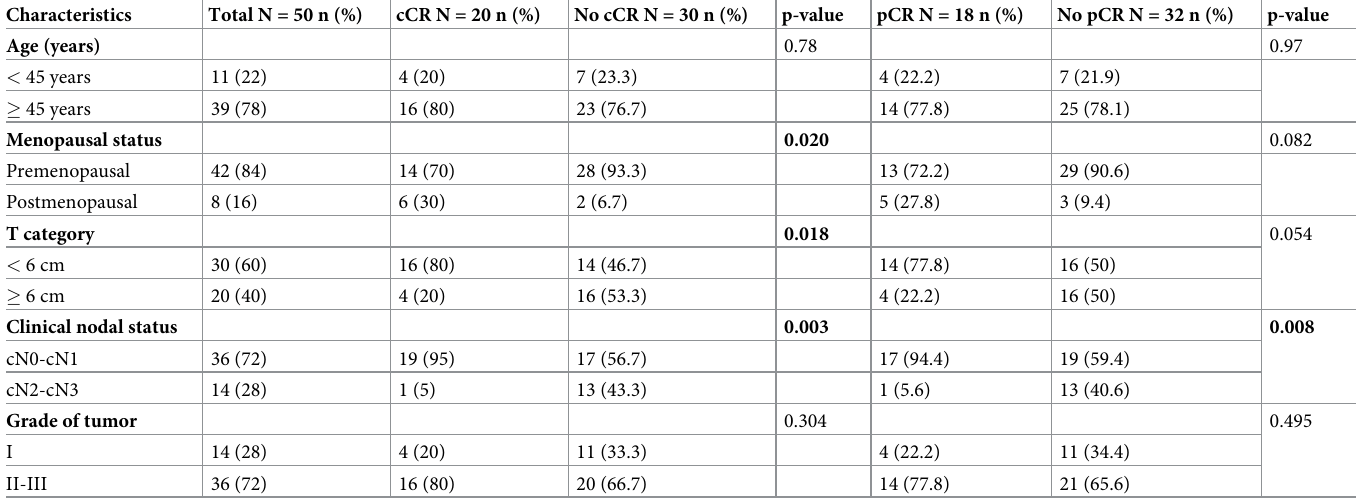
Table 2. Correlation of clinical complete response and pathological complete response with the tumor profile and survival. Characteristics